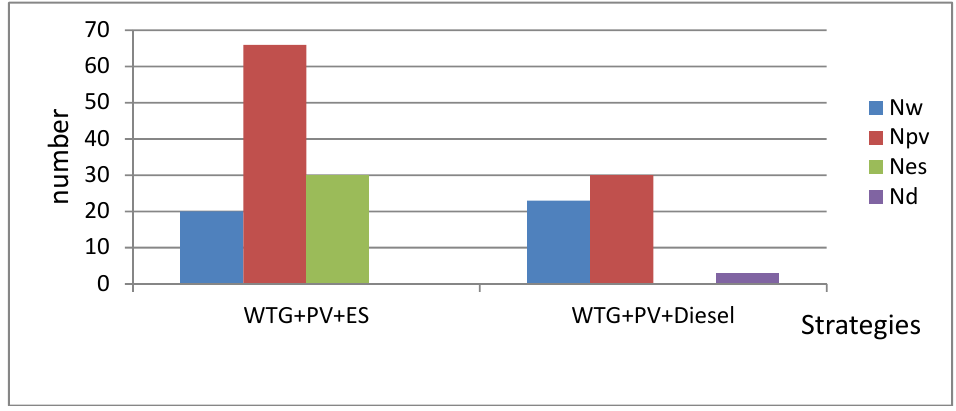
Figure 3. Numbers of WTG, PV, ES, and diesel generators considering two different